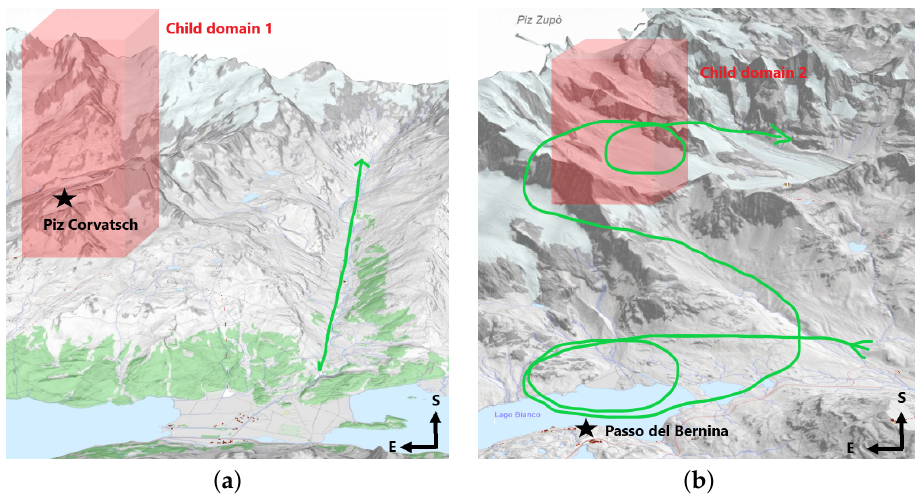
Figure 6. Test scenarios marked in the Swiss federal 3D map viewer for ( a ) the offline flight simulation and ( b ) the piloted flight simulation (source of the original images: the Federal Office of Topography in Switzerland). The green curve in each subfigure represents the hypothetical flight path. The red shadowed zones represent the fluid cells of the child domains of the PALM simulation, which are defined in Figure 4 and Table 2. The black stars indicate the weather stations Piz Corvatsch 3294 m and Passo del Bernina 2260 m